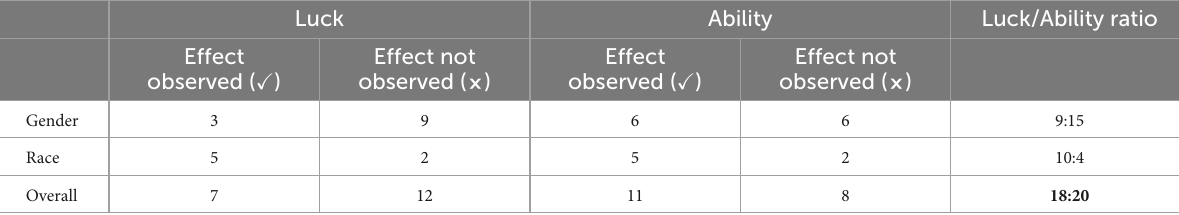
TABLE 3 Quantitative summary of attribution